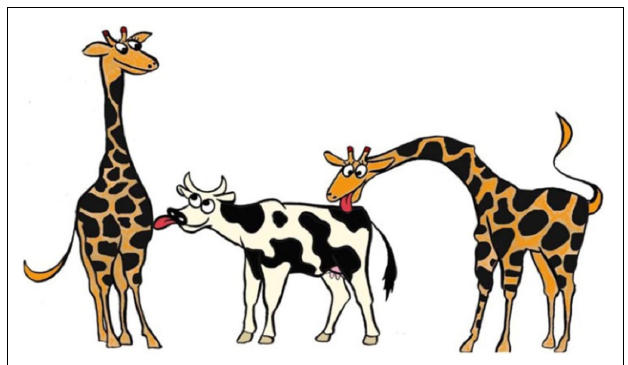
FIGURE 2 | Example of a three characters picture (Hauser et al., 2021: 14). (CC-BY 4.0).